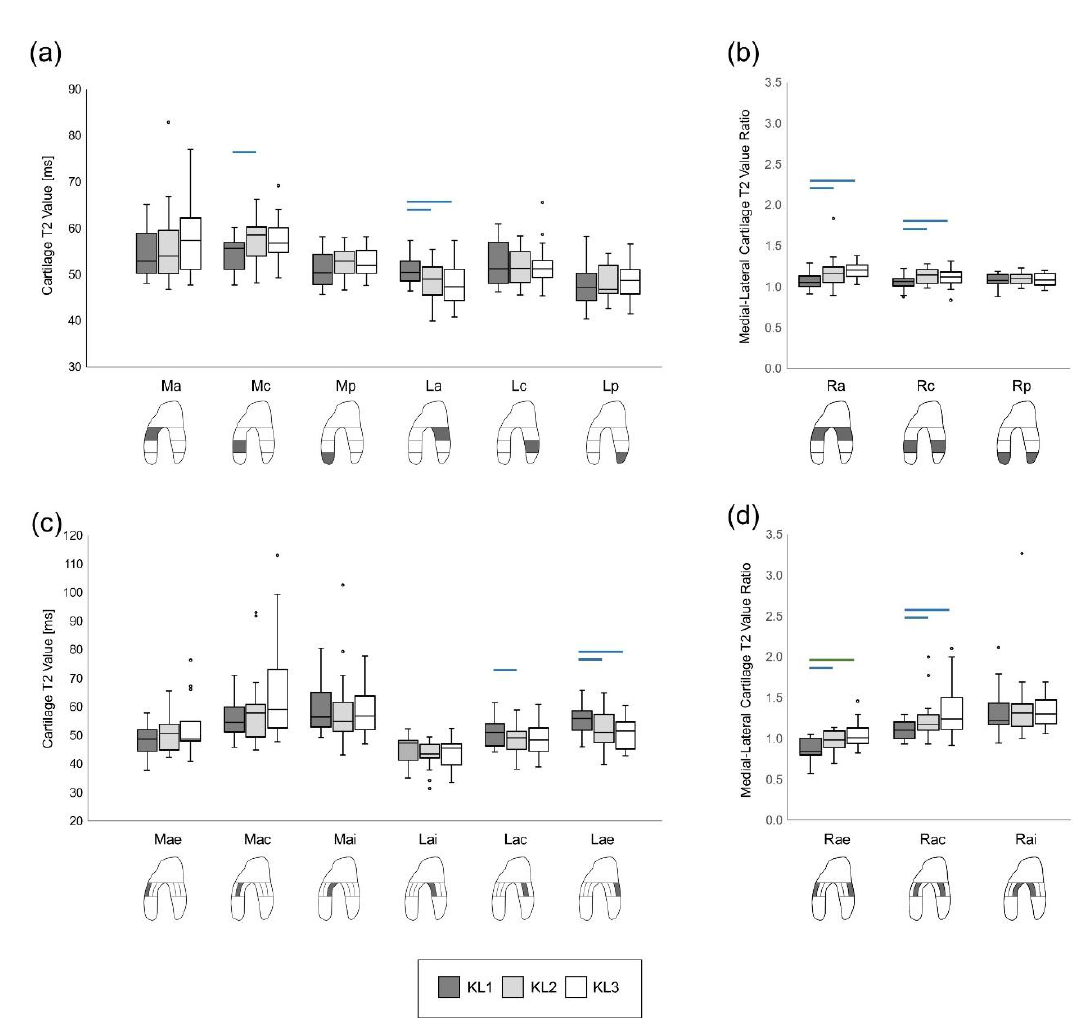
Figure B1. Box and whisker plots of superficial cartilage T2 values per VOI ( a ) and sub-VOI ( c ) and their respective medial-lateral ratios ( b , d ). Horizontal bars indicate statistically significant ( p < 0.017) changes between severity timepoints (blue: ES > 0.5; green: ES > 0.8).